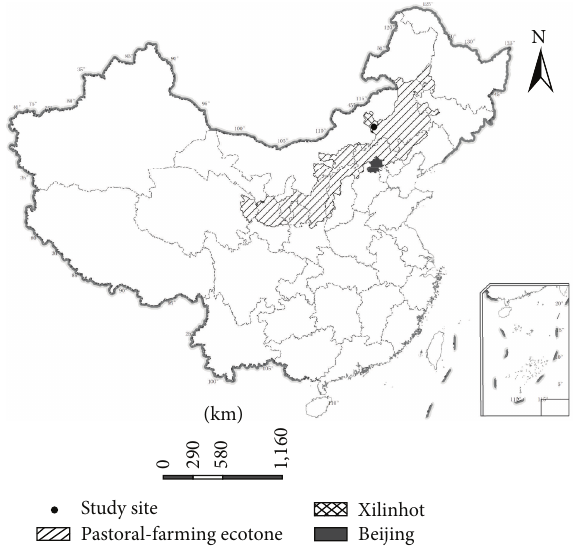
Figure 1: The location of the study area and the pastoral-farming ecotone in Northern China.